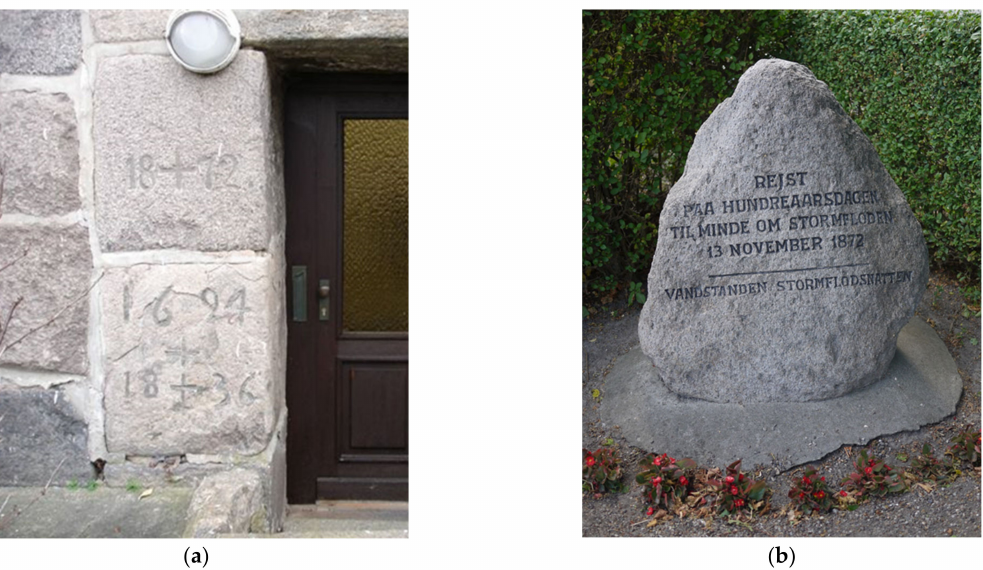
Figure 3. ( a ) Flood marks from 1694, 1836, and 1872 on a building in Schleswig, Germany. Photo: R. Sedlatschek; ( b ) Flood mark at Gedesby church (Gedser, Denmark) to memorize the 100th anniversary of the 1872 storm surge. Photo: